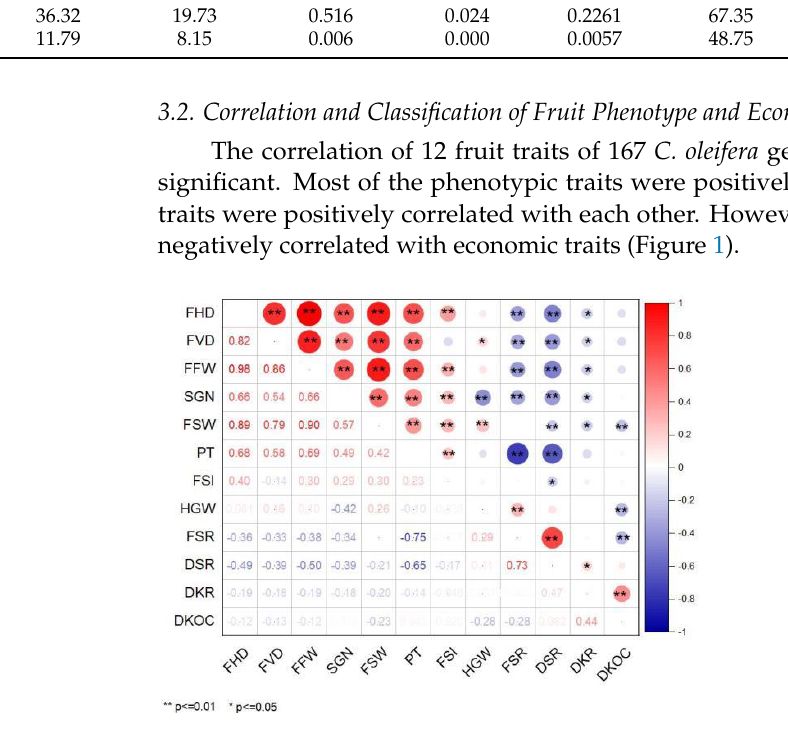
Figure 1. Correlation analysis of fruit traits. Note: In Figure 1, the lower left corner is the Pearson correlation value; in the lower right corner, **, represents a highly significant correlation, p ≤ 0.01; * represents a significant correlation, p ≤ 0.05.